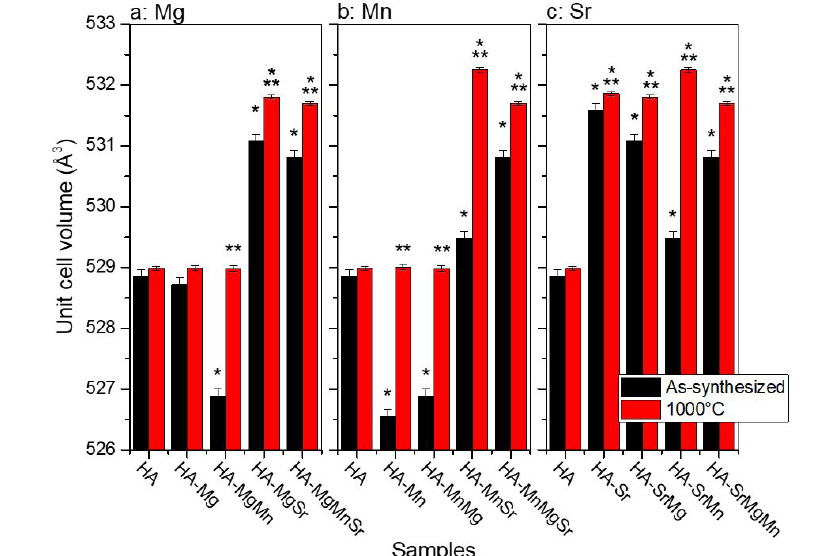
Figure 5. Unit cell volume calculated from the HA phase before and after calcination at 1000°C as a function of the doping elements. The effect of Mn 2+ and Sr 2+ on Mg 2+ (a), the effect of Mg 2+ and Sr 2+ on Mn 2+ (b), and the effect of Mg 2+ and Mn 2+ on Sr 2+ (c). *Significantly different from the HA samples. **Significant difference between the as-synthesized and calcined samples in the same